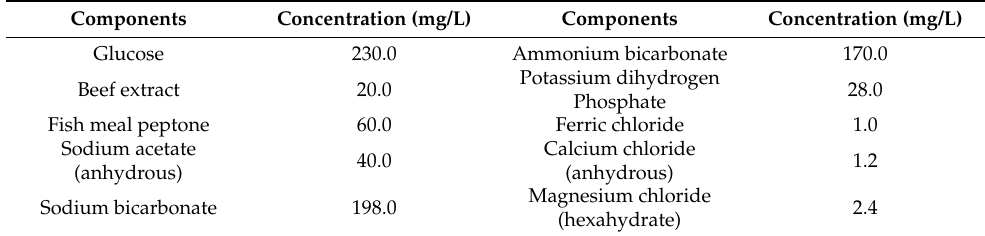
Table 1. The specific components of simulated domestic sewage.